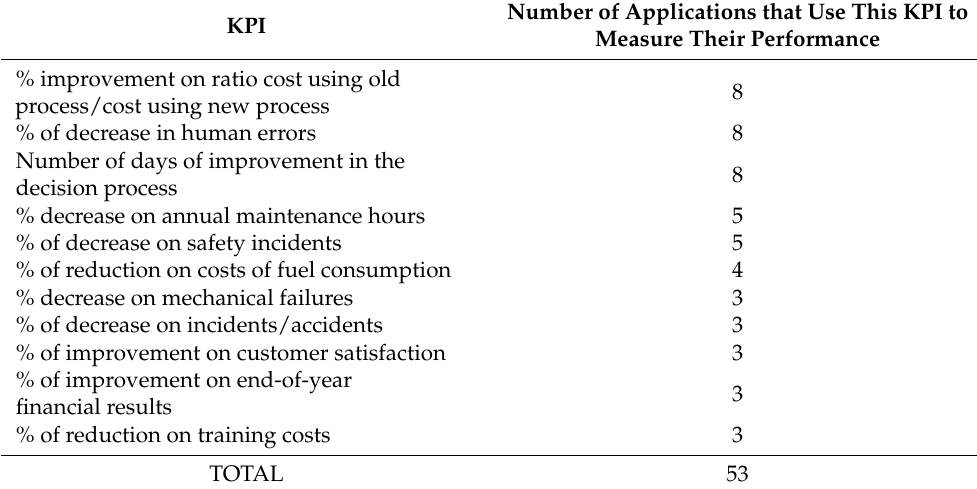
Table 3. KPIs used more than twice for measuring application performance. Number of Applications that Use This KPI to KPI Measure Their